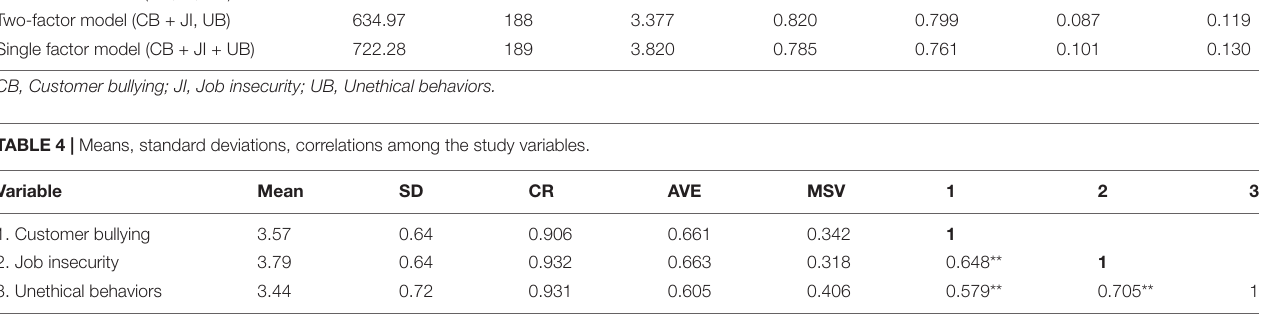
TABLE 3 | Confirmatory factor analysis. Model Three-factor model (CB, JI, UB)